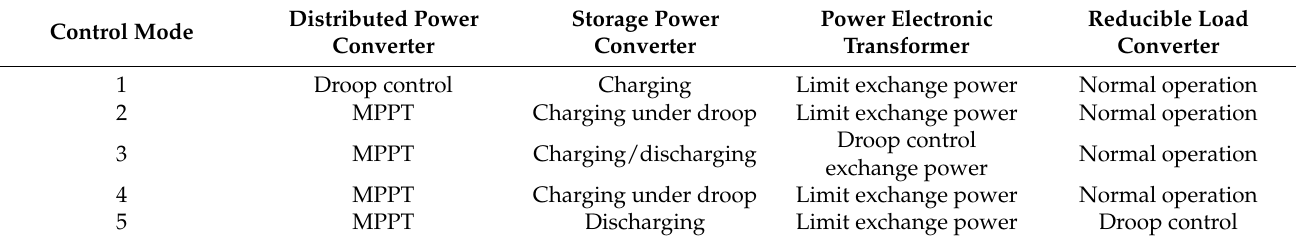
Table 1. Control mode classification of DC microgrid.